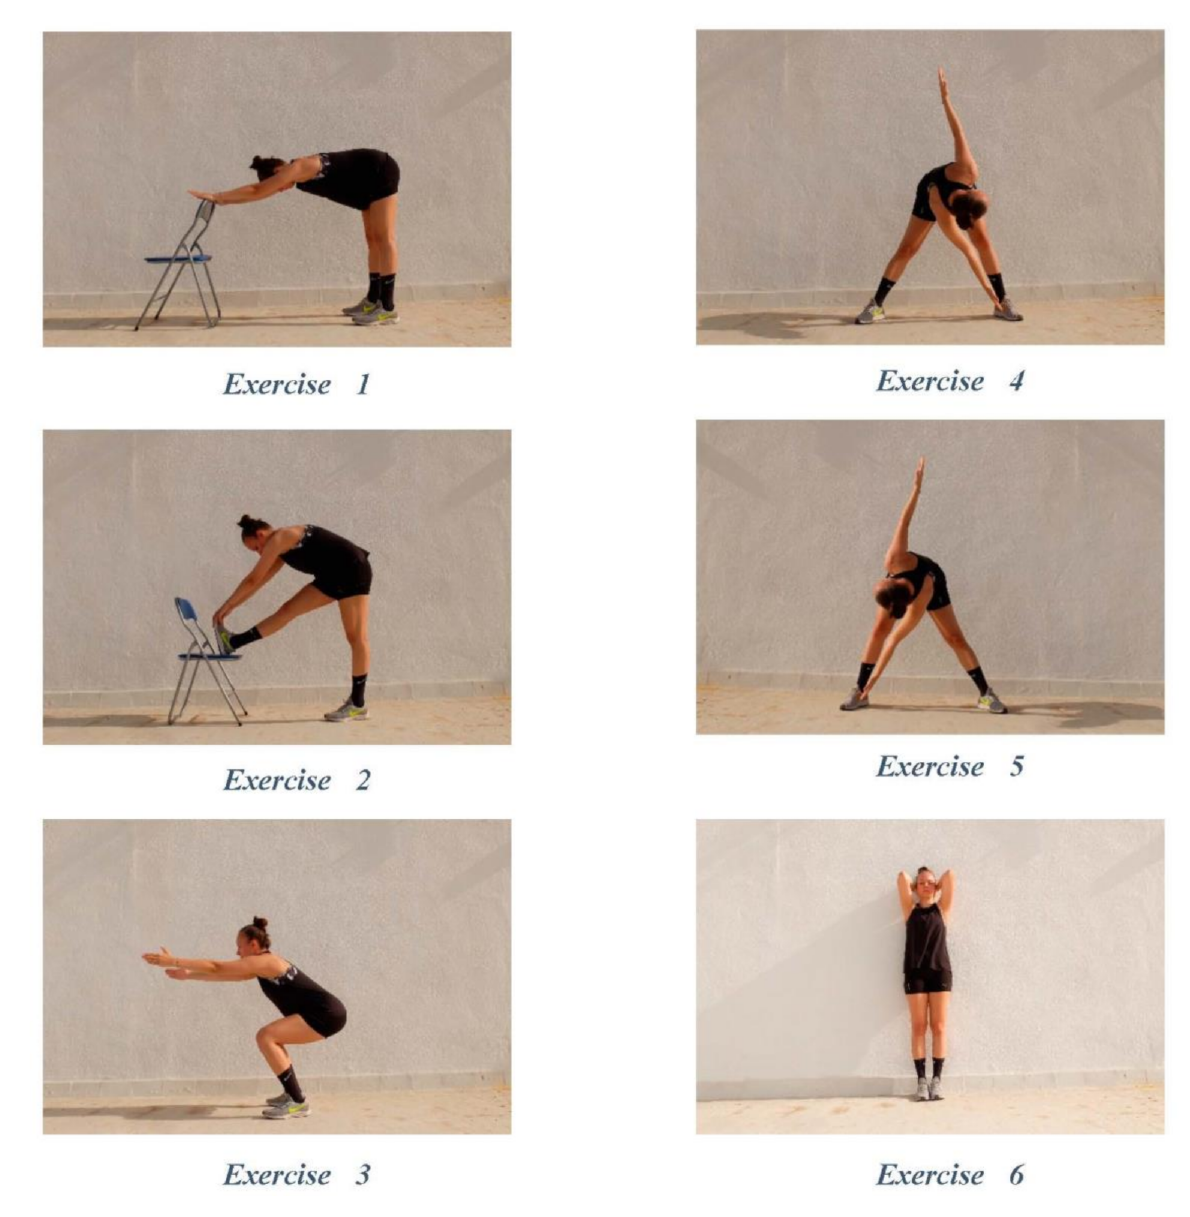
Figure A3. Stretching Exercises